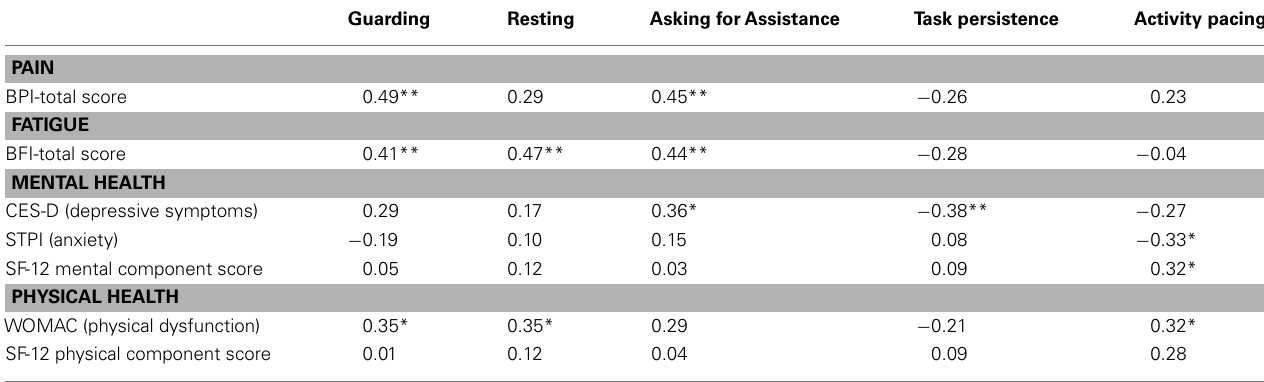
Table 3 | Correlations between CPCI subscales and measures of pain, mental, and physical